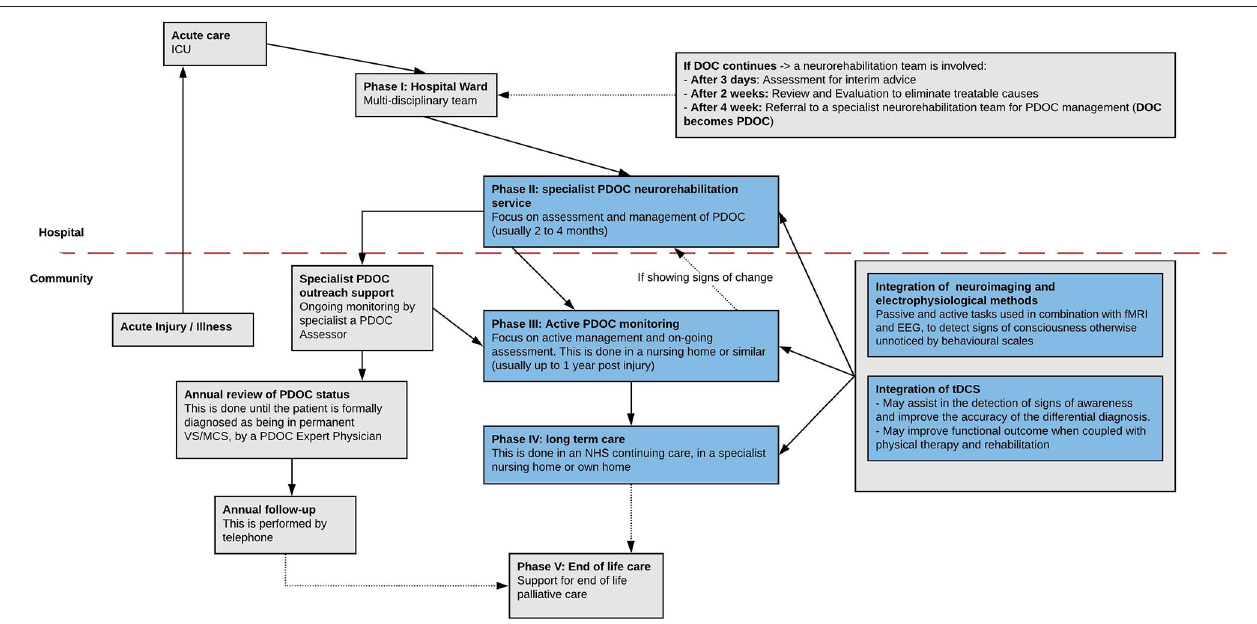
FIGURE 2 | Representation of the pathways of care for PDOC patients as proposed by the Royal College of Physicians (1), with suggestions for the role that tDCS and neuroimaging/electrophysiological methods could play in each of the stages. Reproduced and amended from Royal College of Physicians (